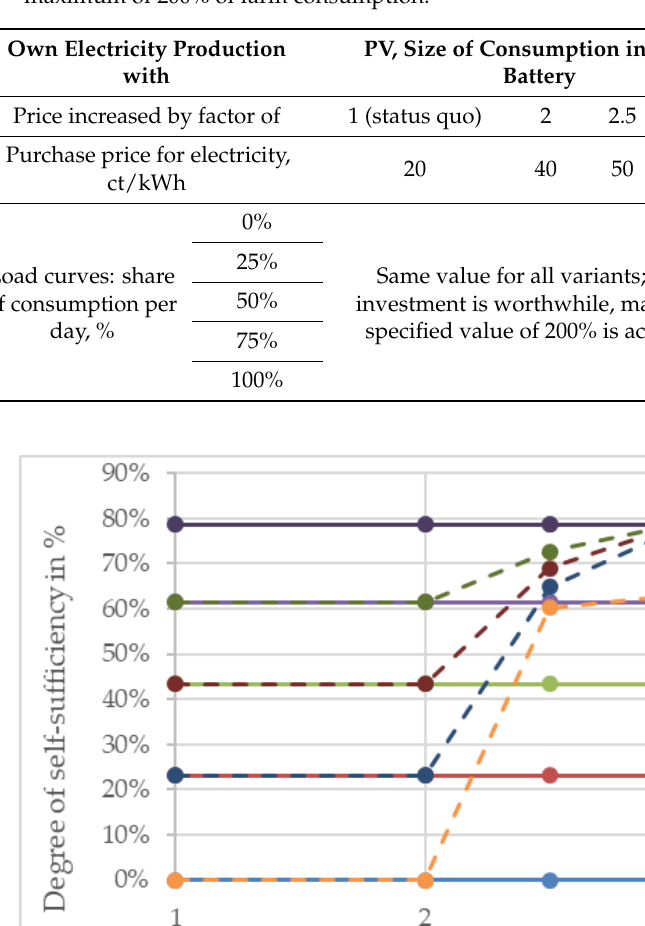
PV and Battery, Battery Coverage in % of